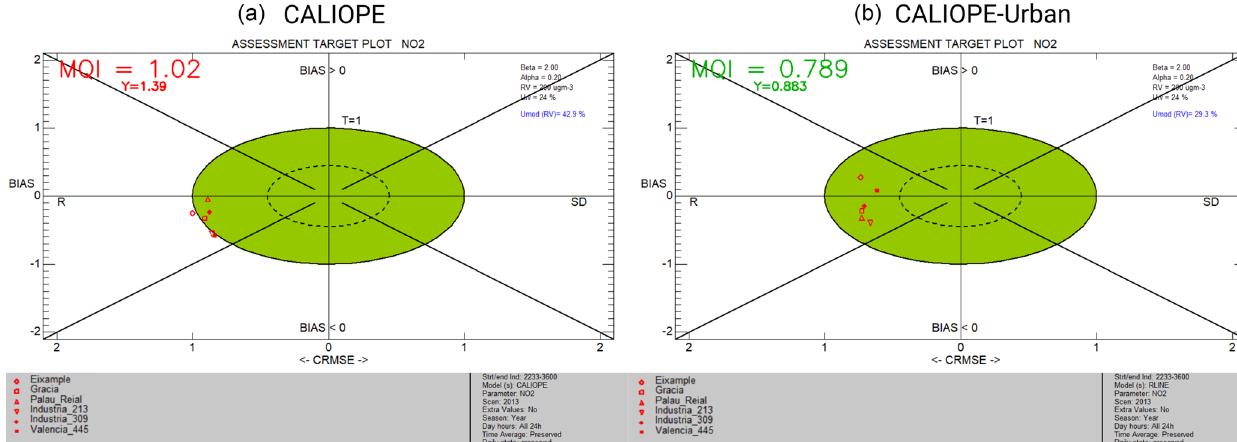
Figure 8. NO 2 model assessment target plots for CALIOPE (left) and CALIOPE-Urban (right). Symbols correspond to the six measurement sites described in Sect. 3.1 and the MQI for each site is represented by the distance between the circle origin and the site symbol.